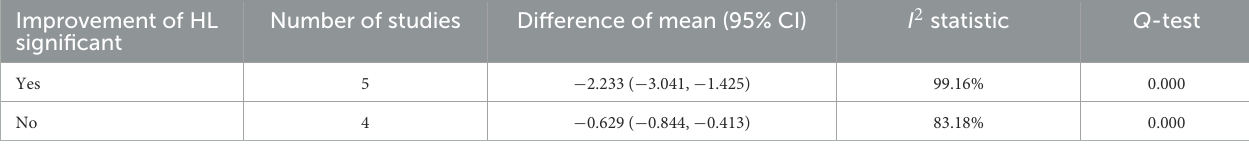
TABLE 5 Effect of the significant improvement in health literacy on affective symptomatology. Improvement of HL Number of significant